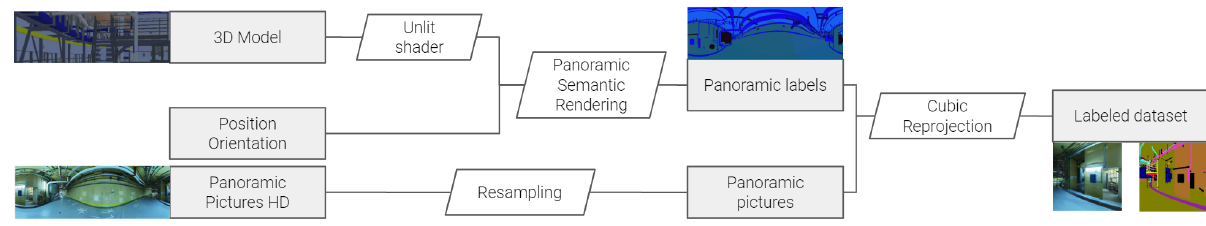
Figure 2. Overview of the procedural label generation pipeline, from a 3D model and panoramic images. x 2048 pixels. Each panorama position and orientation are esti- mated in the coordinate frame of the 3D model using an inter- active procedure detailed in (Hullo et al., 2015), allowing a near perfect overlay of 3D model and panoramas.